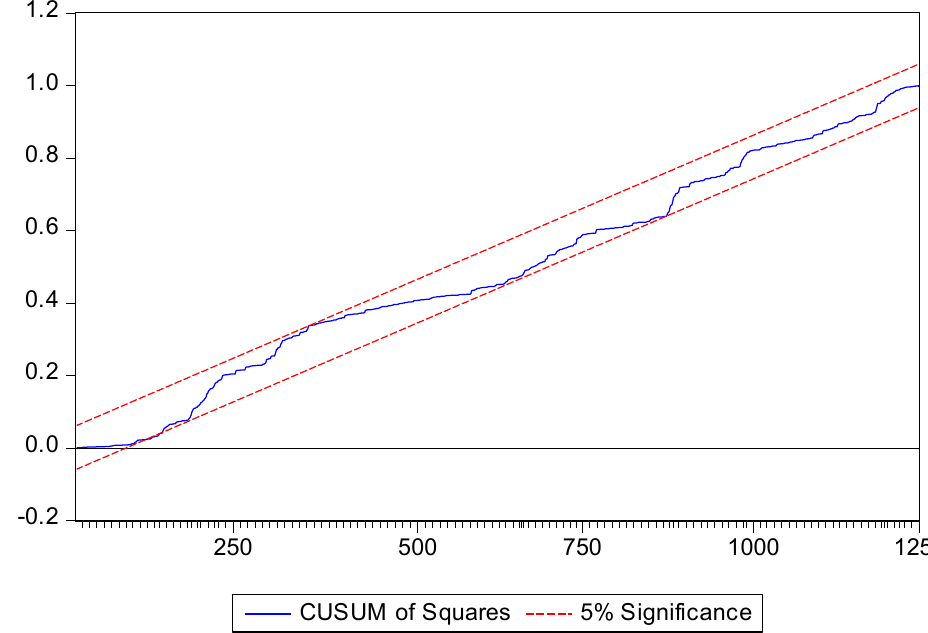
Figure 4. Plots of CUSUMSQ of recursive residuals .